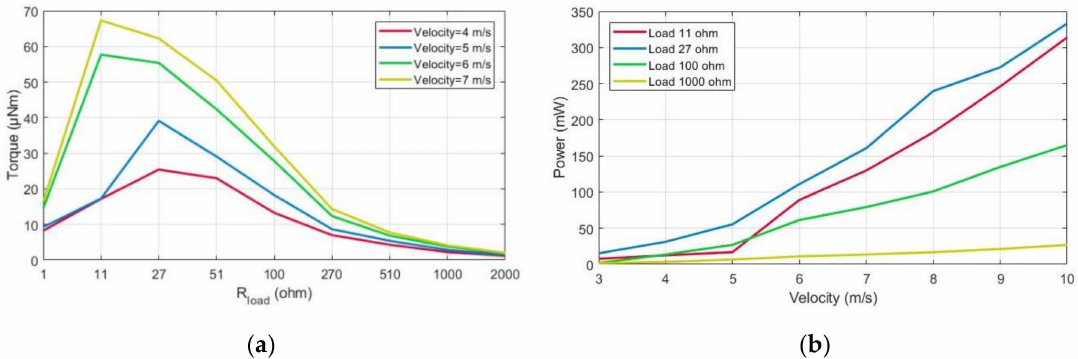
Figure 15. Measured operational values at di ff erent flow velocities and loads. ( a ) Torque representation at di ff erent flow velocities. ( b ) Measured power